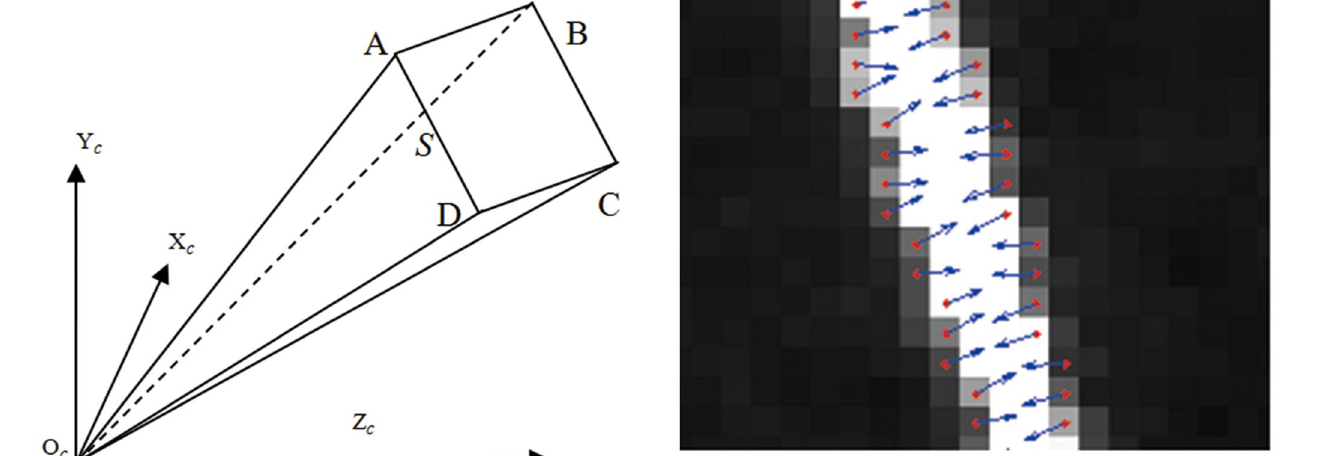
Figure 6. The target plane in camera coordinate frame.